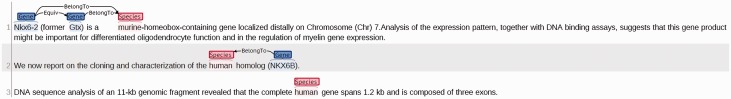
Annotations for the article PMID: 11210186.